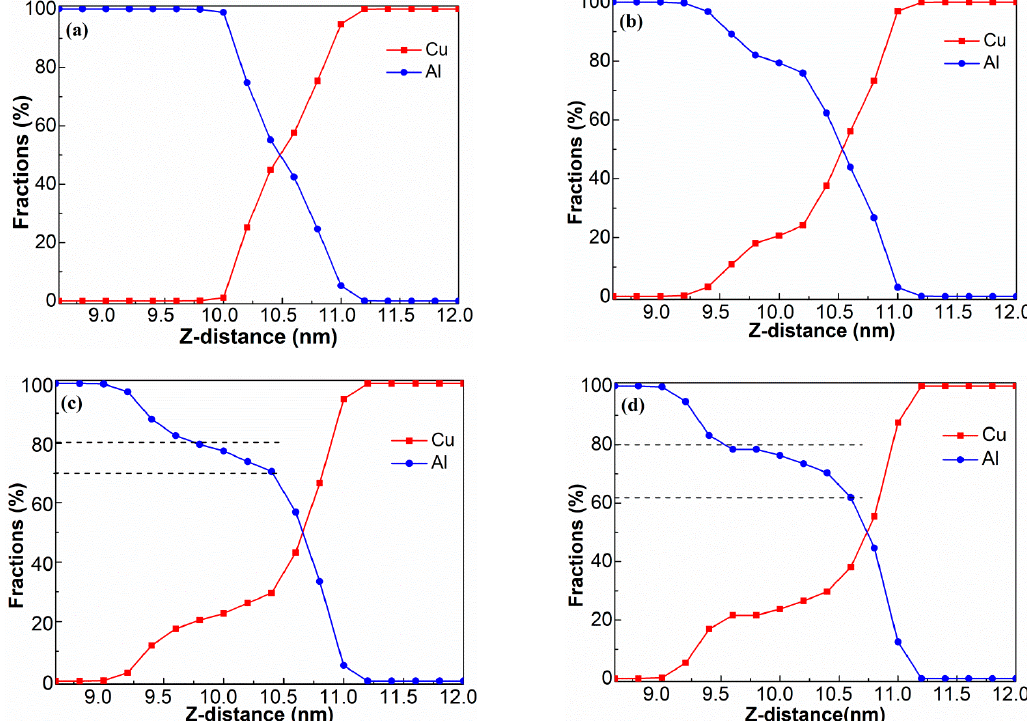
Figure 7. Variation in Al and Cu concentrations along the Z direction obtained at welding times of: ( a ) 0 ns, ( b ) 1 ns, ( c ) 3 ns, and ( d ) 5